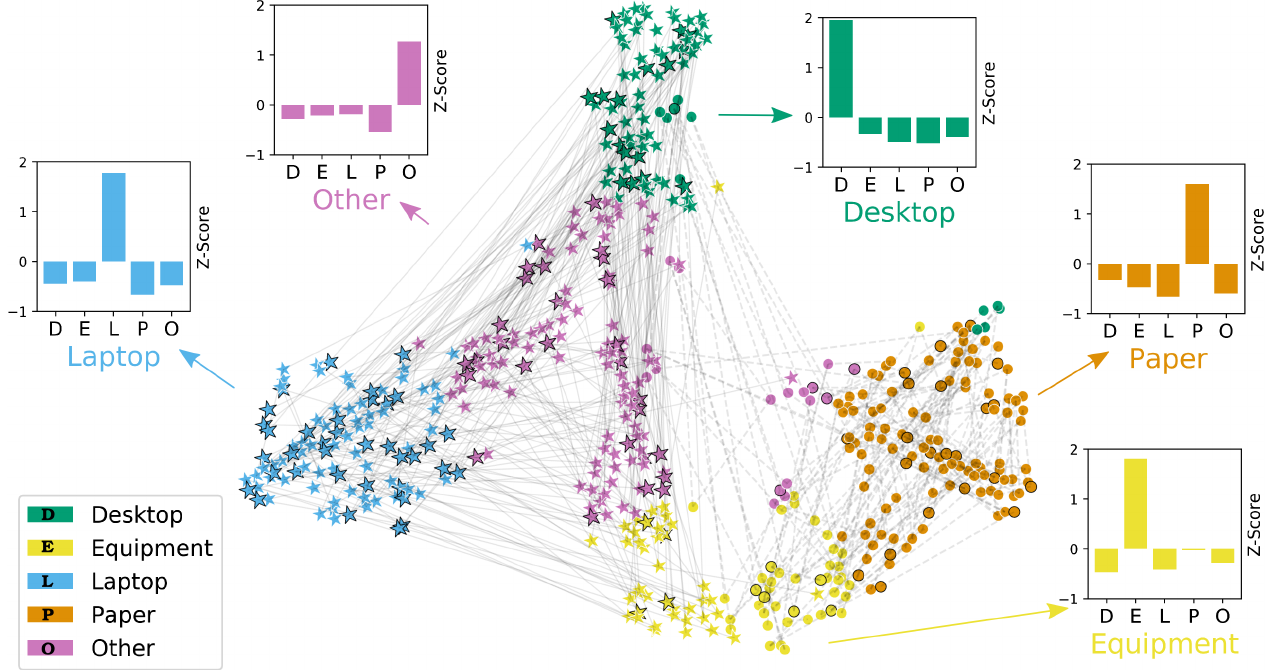
FIG. 4. Two-dimensional visualization of behavior clusters and their centers. Each point represents a unique student profile, with profiles from the same group connected by a gray line (solid for less-structured inquiry labs, and dashed for highly structured traditional labs). Circles represent students in the traditional labs and stars in the inquiry labs, and black edges indicate women ’ s profiles. All points in the laptop cluster are stars, whereas all points in the paper cluster are circles, a reflection of the pedagogical differences in the labs (students in the traditional labs were filling out paper worksheets, whereas in the inquiry labs were filling out electronic notebooks). Clusters are characterized by their centers, and here the centers of the five clusters are given by large Z scores for each of our